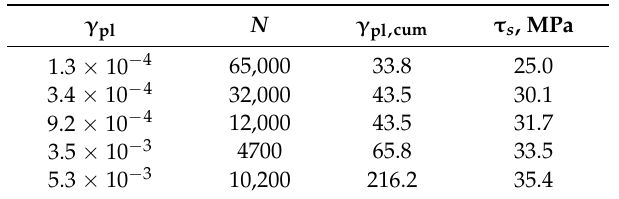
Table 1. Pre-fatigue testing conditions and data for the [ 233 ] Cu single crystal [10]. Note that γ pl is the plastic strain amplitude, N is the cyclic number, γ pl,cum is the cumulative plastic strain (=4 N γ pl ), and τ s is the saturation